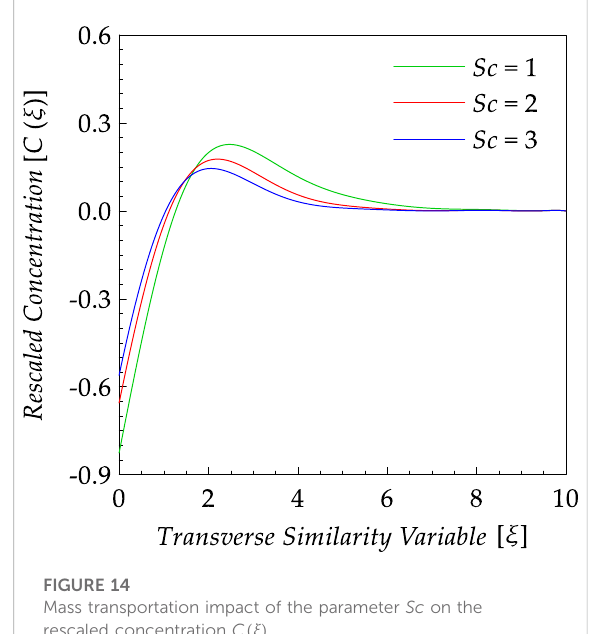
FIGURE 12 Mass transportation impact of the parameter E on the rescaled concentration C ( ξ ) .